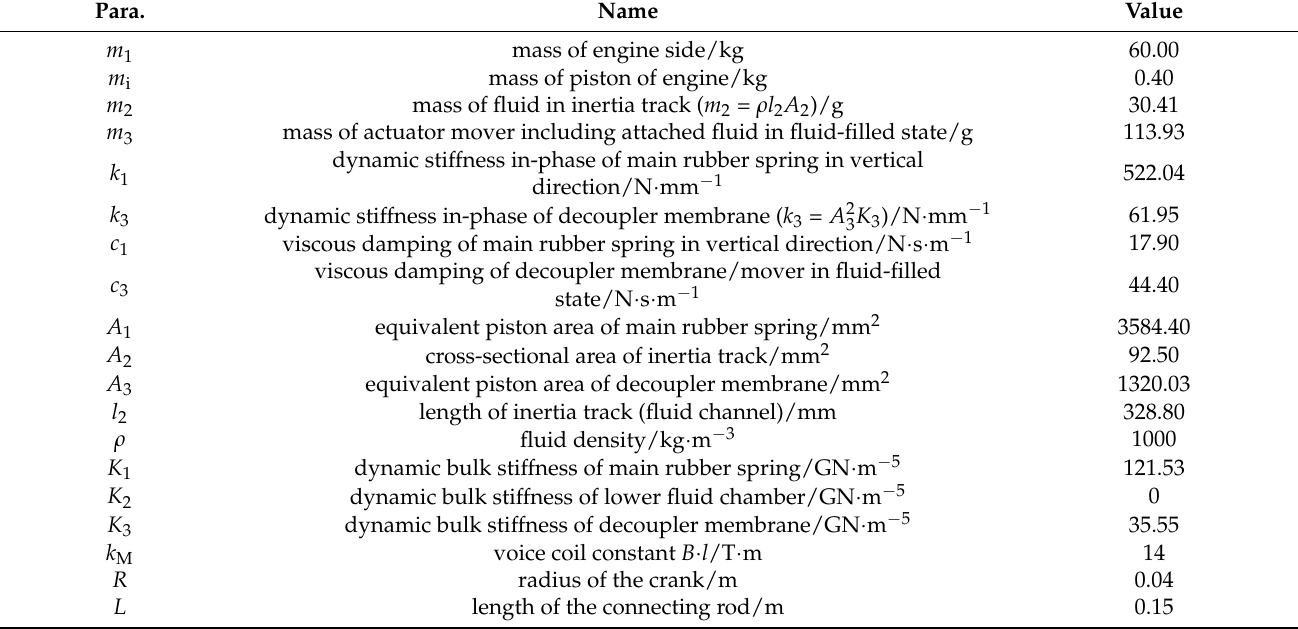
Table 1. The parameters of the ACM with oscillating coil actuator (OCA).